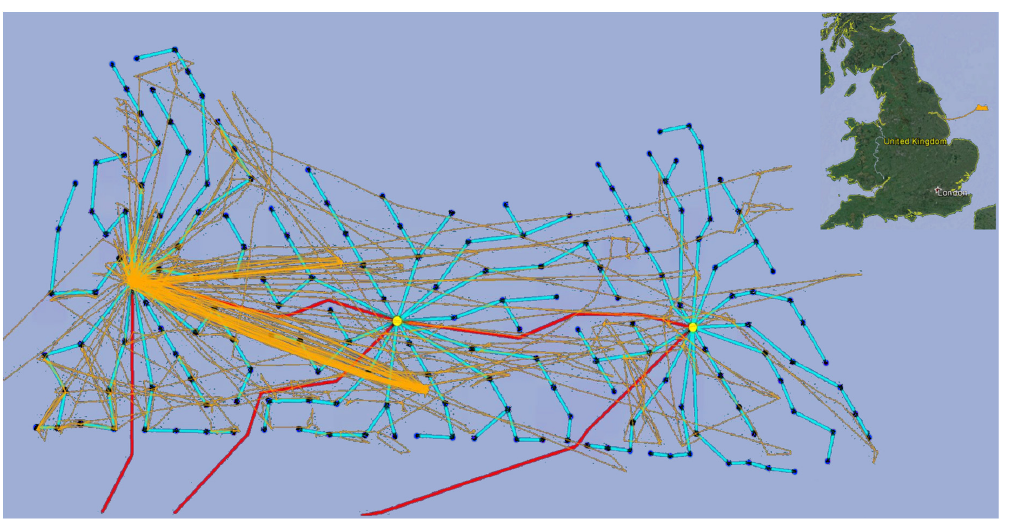
Figure 4. Infrastructure arrangement view of an example Hornsea Project One wind farm near United Kingdom: wind towers (black dots); power cables connecting towers (cyan lines); distribution stations (yellow dots); power cables connecting distribution stations to the land station (red lines). Lines in shades of orange mark the route of CTV, MHO GRIMSBY, undertaken in the period from 20/06/2019 to 06/07/2019 [22,43].